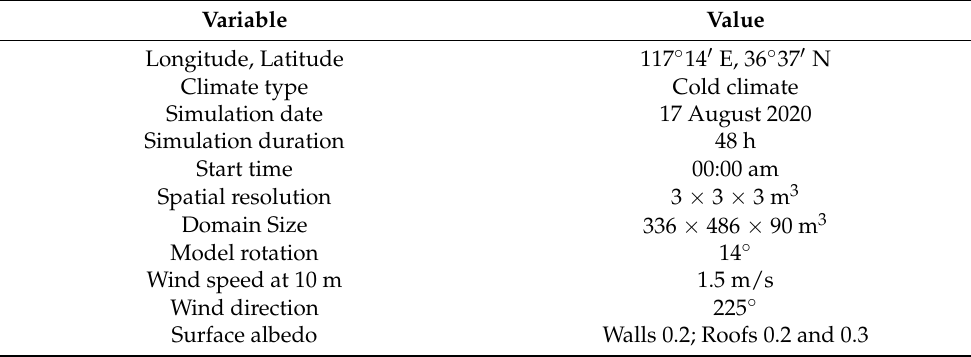
Table 3. Simulation conditions used in ENVI-met.